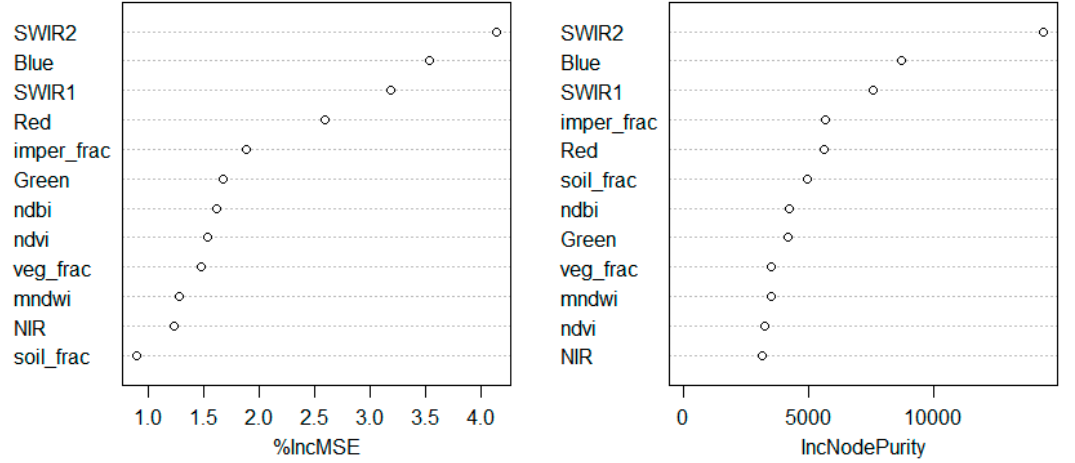
Figure 10. RF importance ranking of independent variables for region A; imper_frac, veg_frac, and soil_frac stand for impervious surface, vegetation, and soil fractions, respectively. MNDWI is the modified normalized difference water index, NDBI is the normalized difference built-up index, and NDVI is the normalized difference vegetation index.